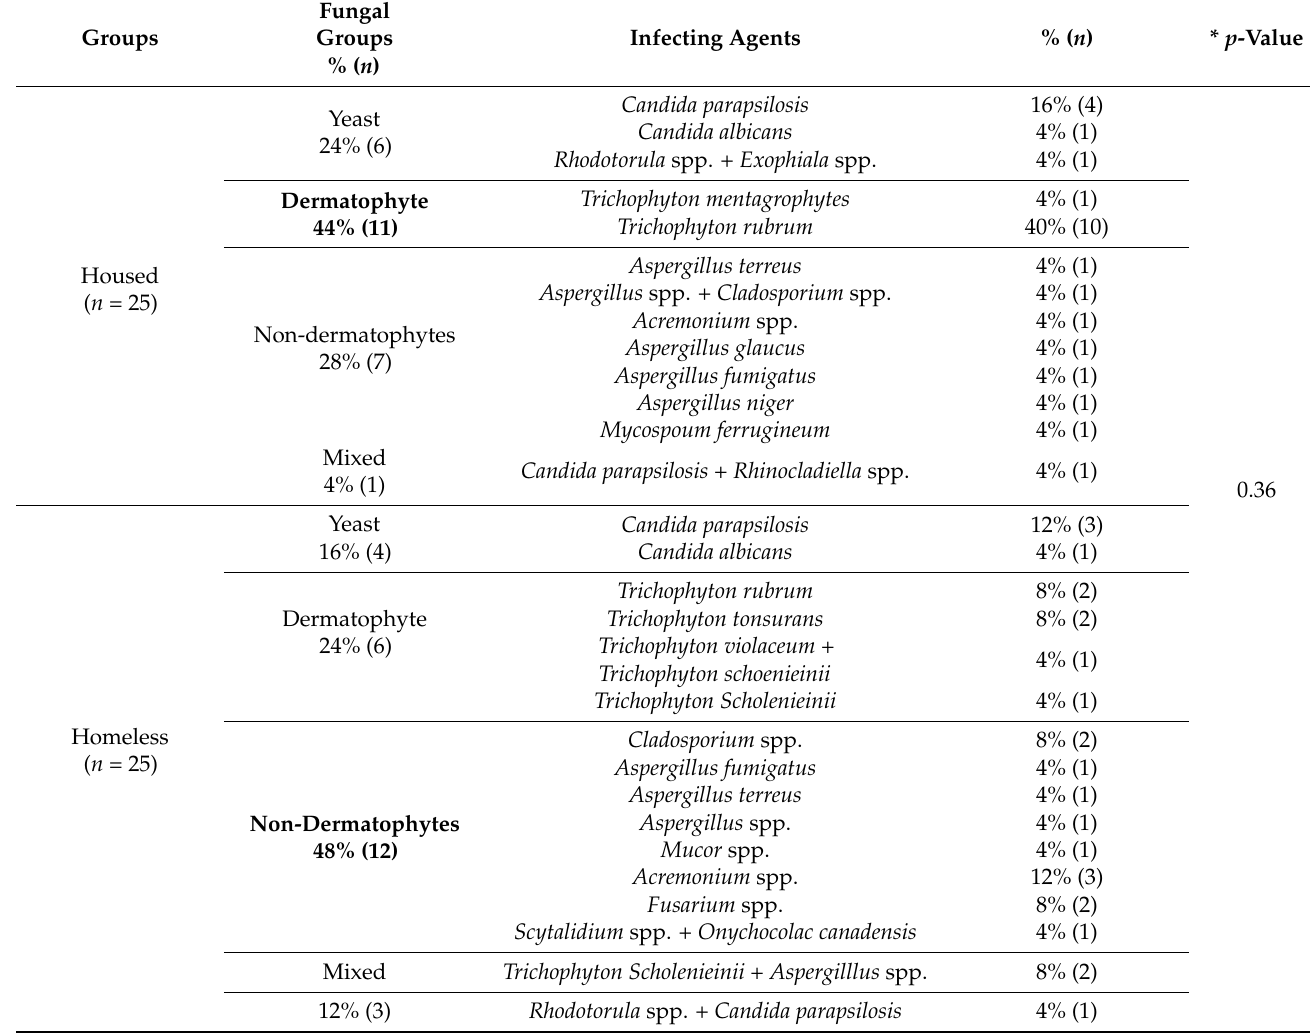
Table 2. Relationship between groups of fungi and infectious agents with study group ( n = 50).